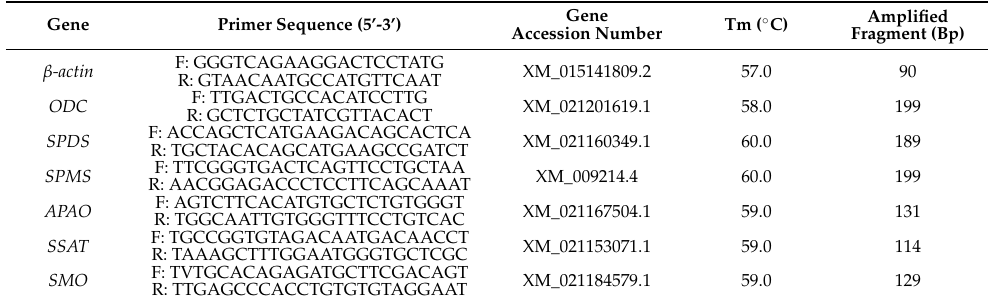
Table 3. Primer sequences used in q